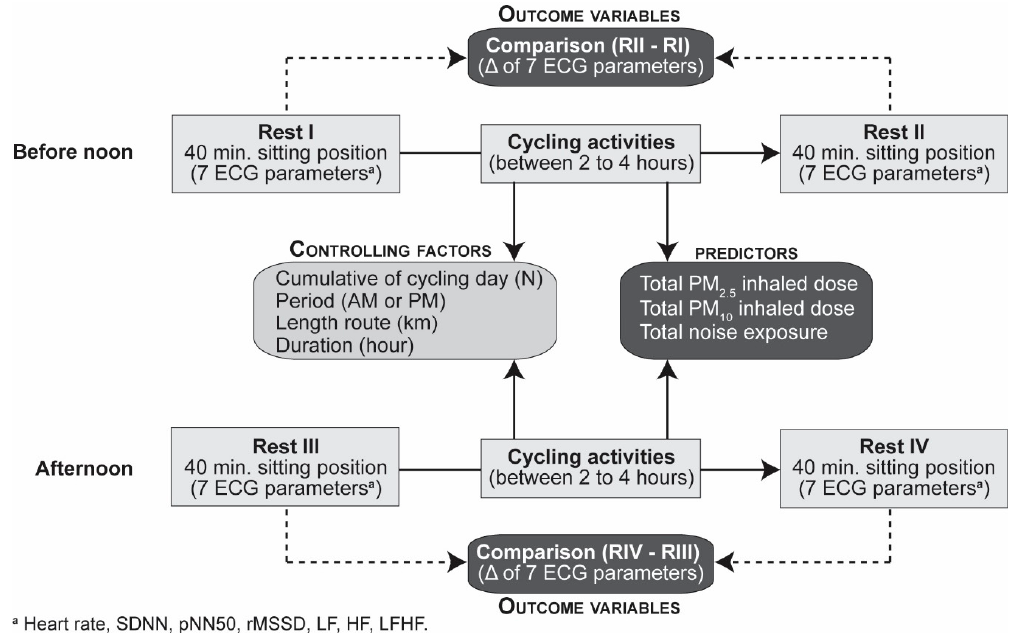
Figure 1. Evaluation framework. Electrocardiogram (ECG) parameters: heart rate (HR), standard deviation of the normal-to-normal intervals (SDNN), percentage of successive RR intervals that differ by more than 50 ms (pNN50), root mean square of successive RR interval differences; LF, low-frequency power (rMSSD), high-frequency power (HF), ratio of low- to high-frequency power (LF/HL). Particulate matter of less than 2.5 µm in diameter (PM 2.5 ), particulate matter of less than 10 µm in diameter (PM 10 ).